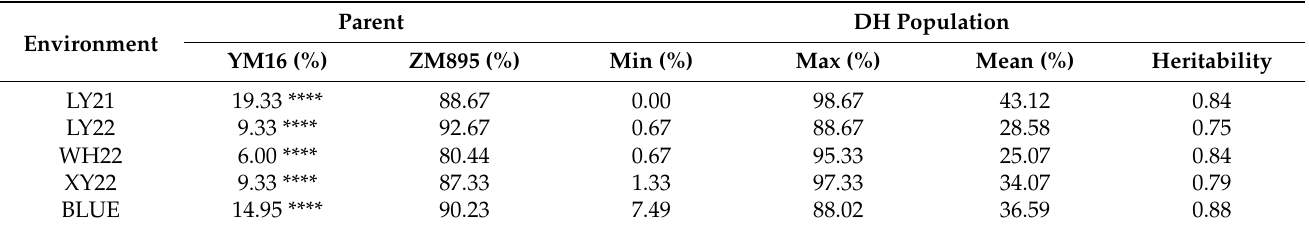
Table 2. GP of the YM16/ZM895 double haploid population and its parents in multiple